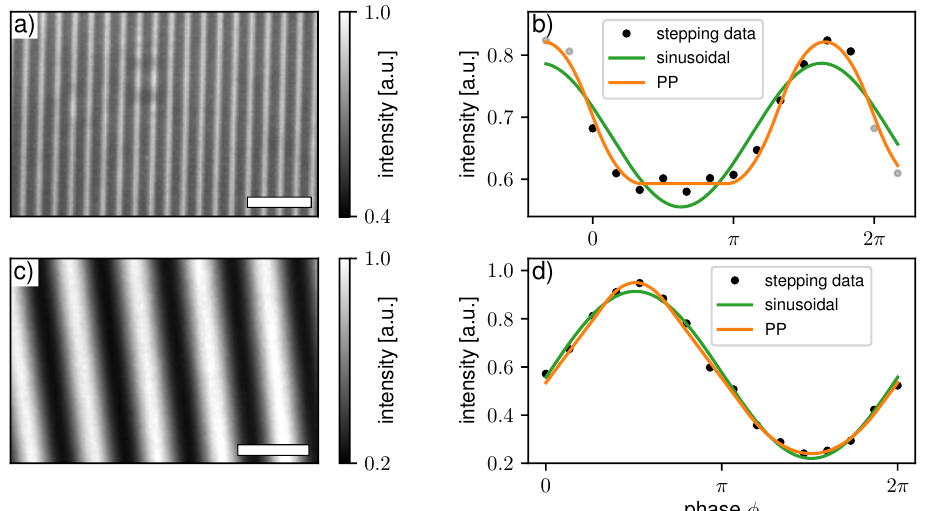
Figure 7. Detector image of a flat-filed intensity modulation for the ( a ) 1-grating X-ray interferometer and ( c ) 3-grating neutron interferometer. Measured stepping data and fitted curves using a sinusoidal function and I PP of a single detector pixel for the ( b ) one-grating X-ray interferometer and ( d ) three- grating neutron interferometer. For a better visualization in ( b ), the stepping data were periodically continued in both directions (gray markers). The white scale bars in ( a , c ) represent 20µm and 10mm,